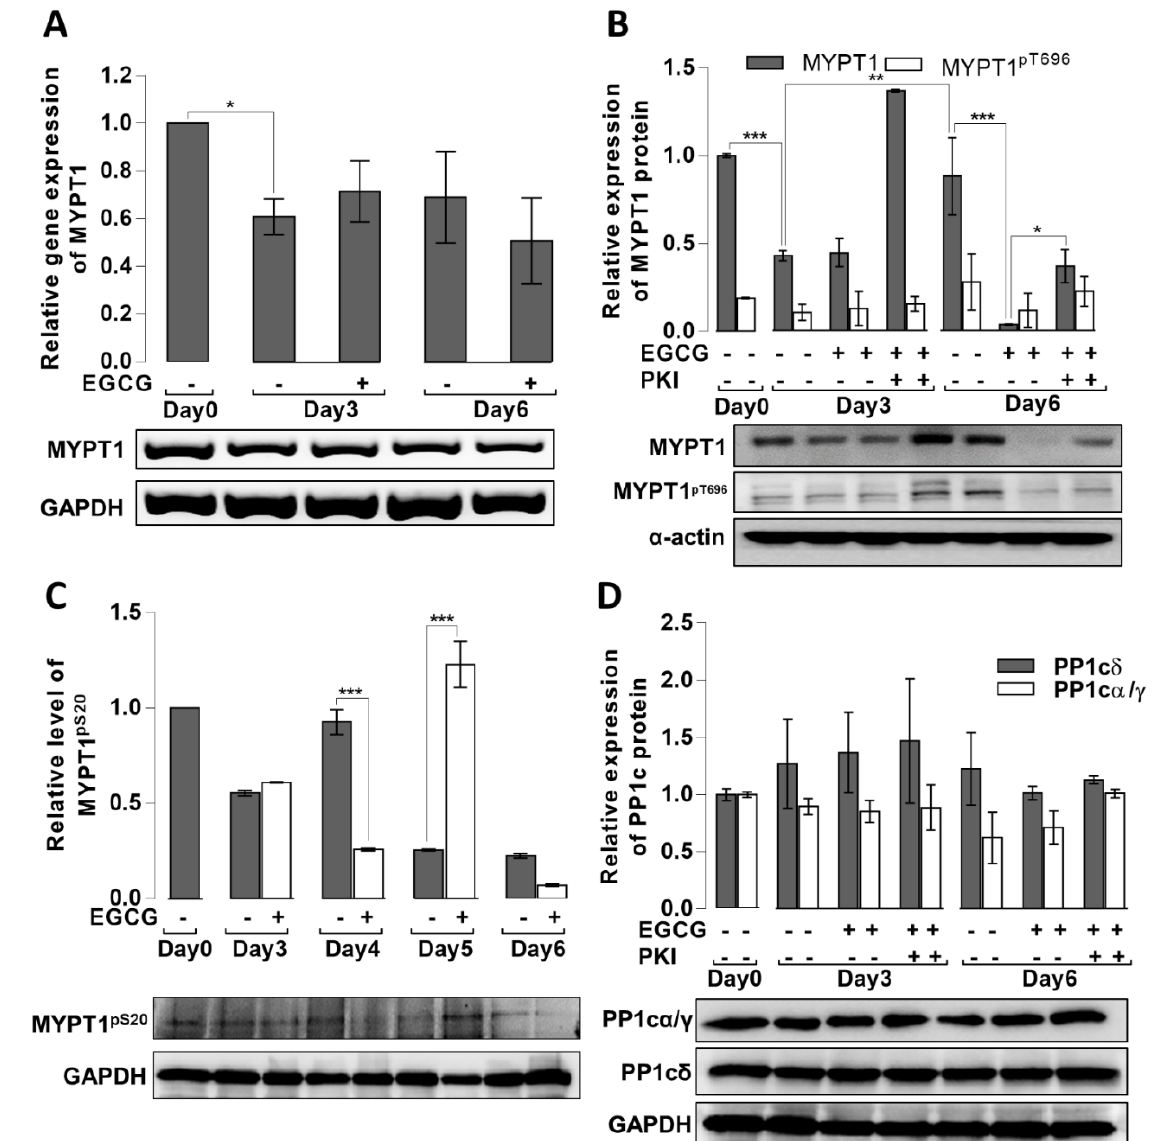
Figure 5. Expression and phosphorylation of MYPT1 and PP1c isoforms during the adipogenic differentiation of MSCs. MSCs were differentiated in the absence or presence of EGCG (20 µ M) or EGCG plus PKI (20 µ M). ( A ) Expression of the MYPT1 gene was assessed, as described in the Materials and Methods section. ( B ) MYPT1 protein levels and phosphorylation at Thr696 were determined by Western blots using anti-MYPT1 1-296 and anti-MYPT1 pThr696 antibodies. ( C ) Phosphorylation of MYPT1 at Ser20 determined by Western blots using an anti-MYPT1pSer20 antibody. ( D ) Assessment of protein expression of PP1c isoforms using PP1c δ and PP1c α / γ 1 specific antibodies. Representative blots are shown. Bar graphs represent densitometric analysis of the blots ( n = 3). Statistical analysis: two-way ANOVA: * p < 0.05, ** p < 0.01, *** p < 0.001, n.s.: